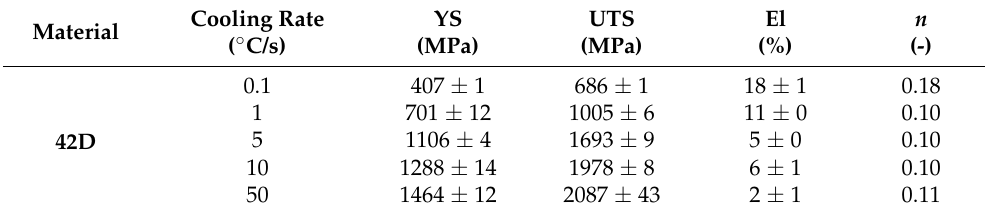
Table 4. Results of mechanical properties determined from mini-tensile tests for 42D steel according to the experimental cooling rates (YS: yield strength, UTS: ultimate tensile strength, El: total elongation at fracture, n : work-hardening exponent).